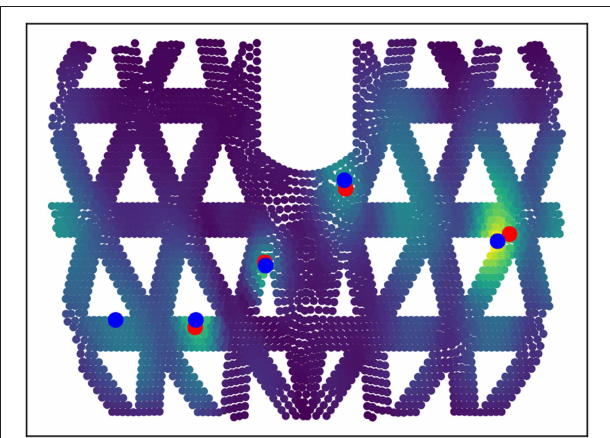
FIGURE 7 | Quadruple contact information extraction. Based on the predicted deformation map (lighter color indicates stronger deformation), the multiple contact locations are extracted using the proposed k-Max method. Blue dots are the predicted contact locations and red dots show the ground truth.